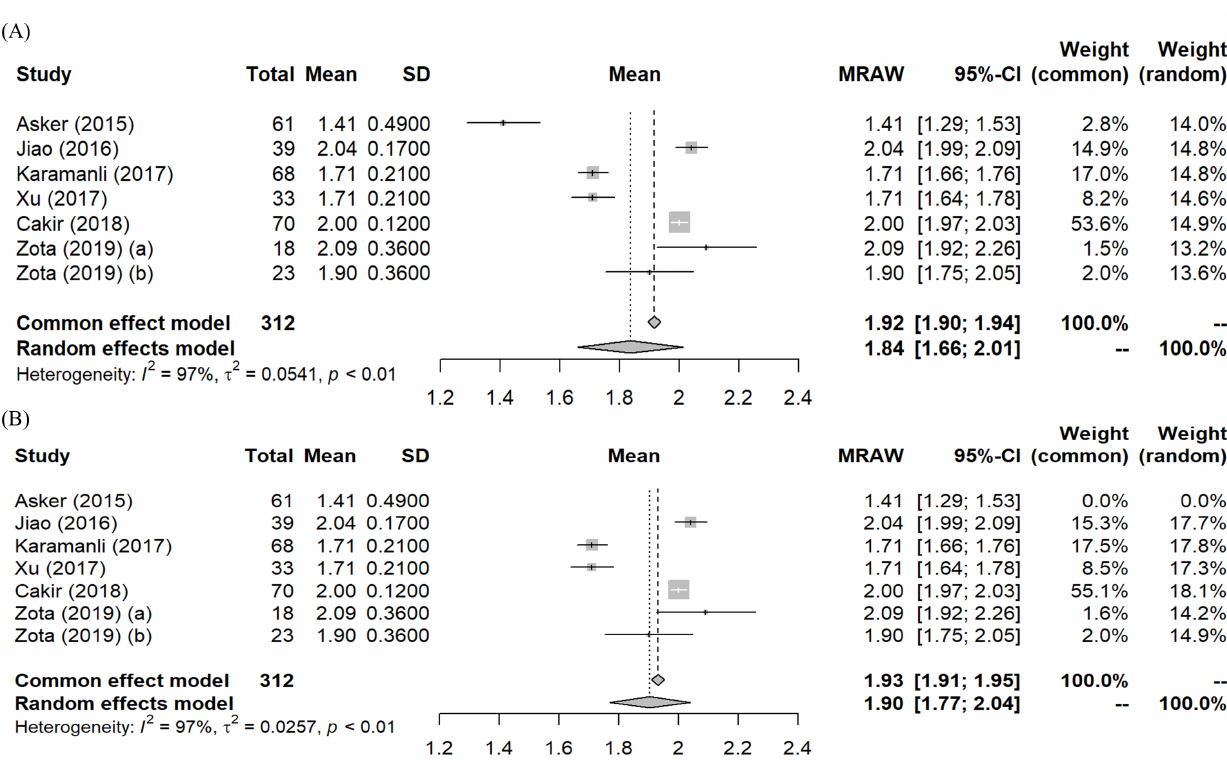
Figure 3. Forest plots–Meta-analyses of the mean serum Mg levels based on: (A) All included studies [21–26]; (B) After exclusion of Asker et al. [21]. (MRAW = untransformed mean). Two mean values were reported by Zota et al. [26]: ( a ) moderate OSA; ( b ) severe OSA. Both values were included in the